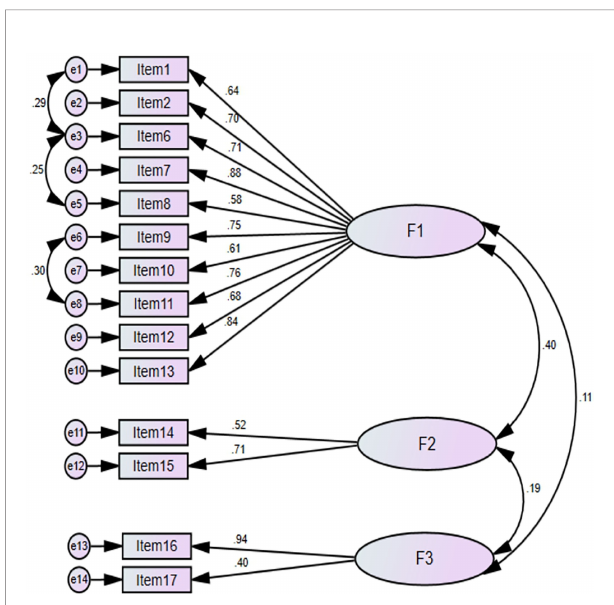
FIGURE 3 | CFA model diagram with standardized regression weights. Factor-1, Financial and Psychosocial affect domain; Factor-2, Coping behaviour domain; Factor-3, Support seeking